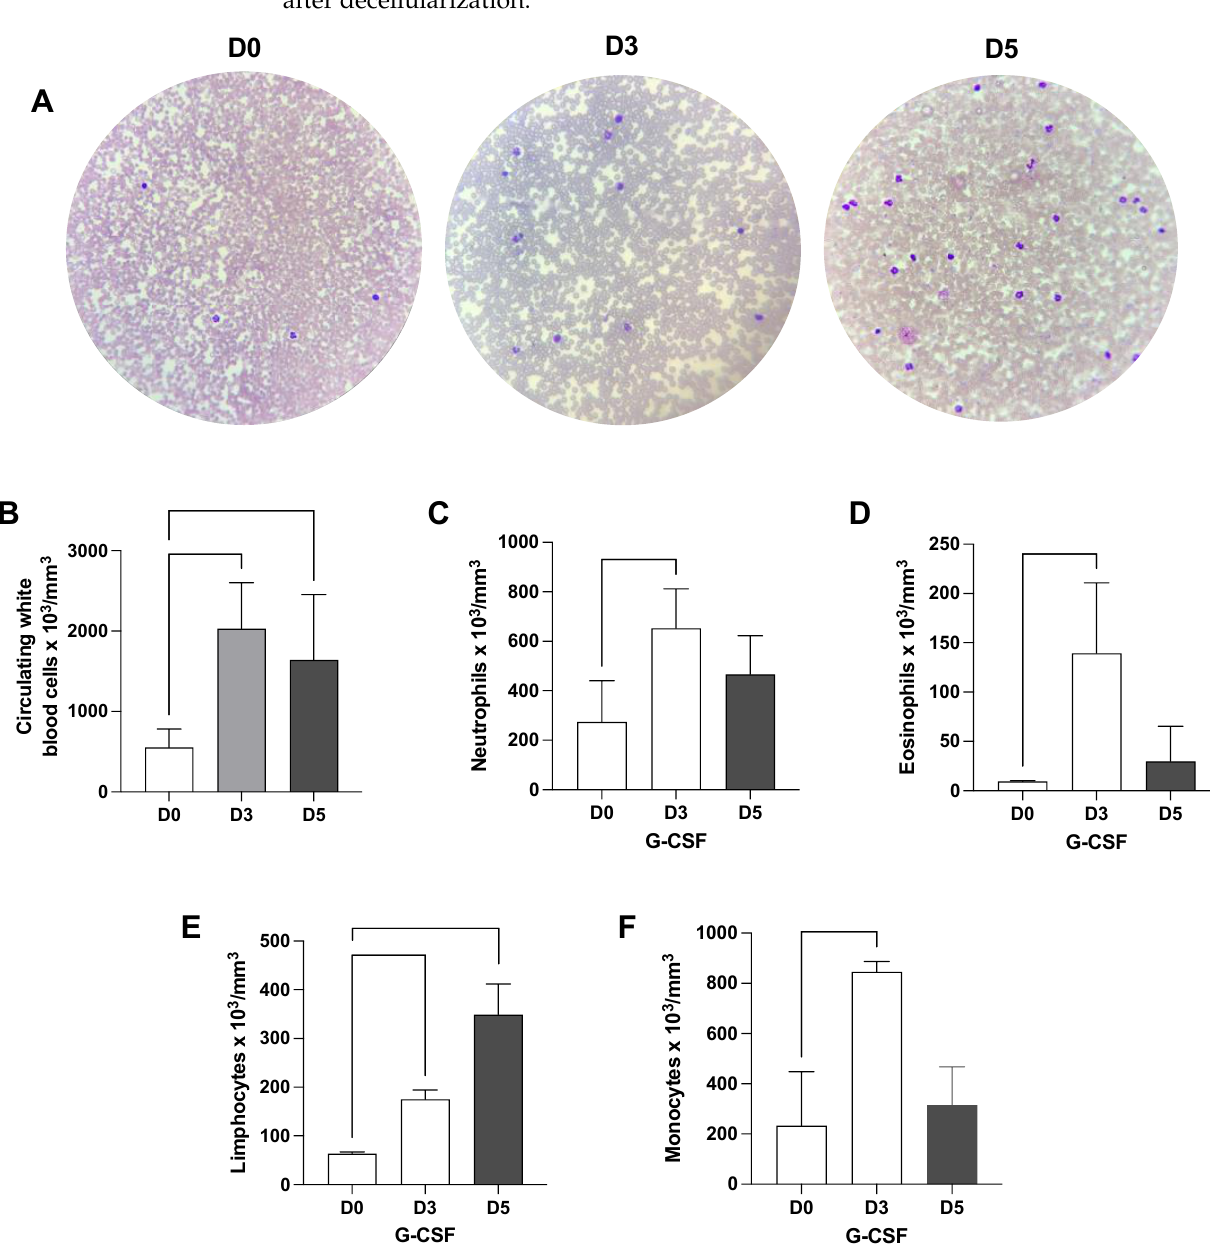
Figure 3. G-CSF induces white blood cell mobilization to the peripheral blood. Blood samples were subjected to Panoptic fast staining to reveal white blood cells before and 3 and 5 days after G-CSF treatment ( A ). Hemogram analysis ( B – F ) of cirrhotic rats before and after 3 and 5 injections of G-CSF. G-CSF treatment significantly enhanced leukocyte numbers in the peripheral blood of cirrhotic rats. Statistical significance was assessed by using paired Student’s t -test analysis ( n = 3).